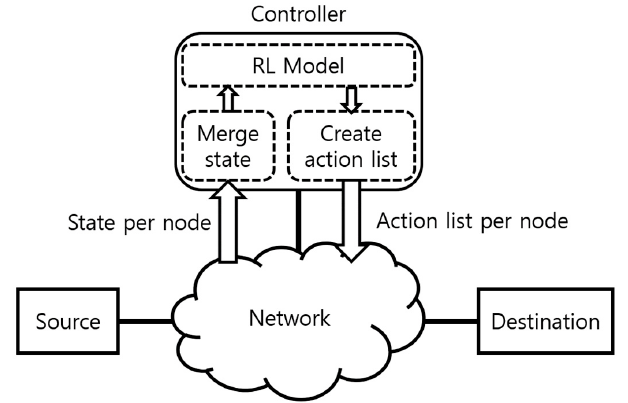
Figure 3. Full environment structure in SARL.